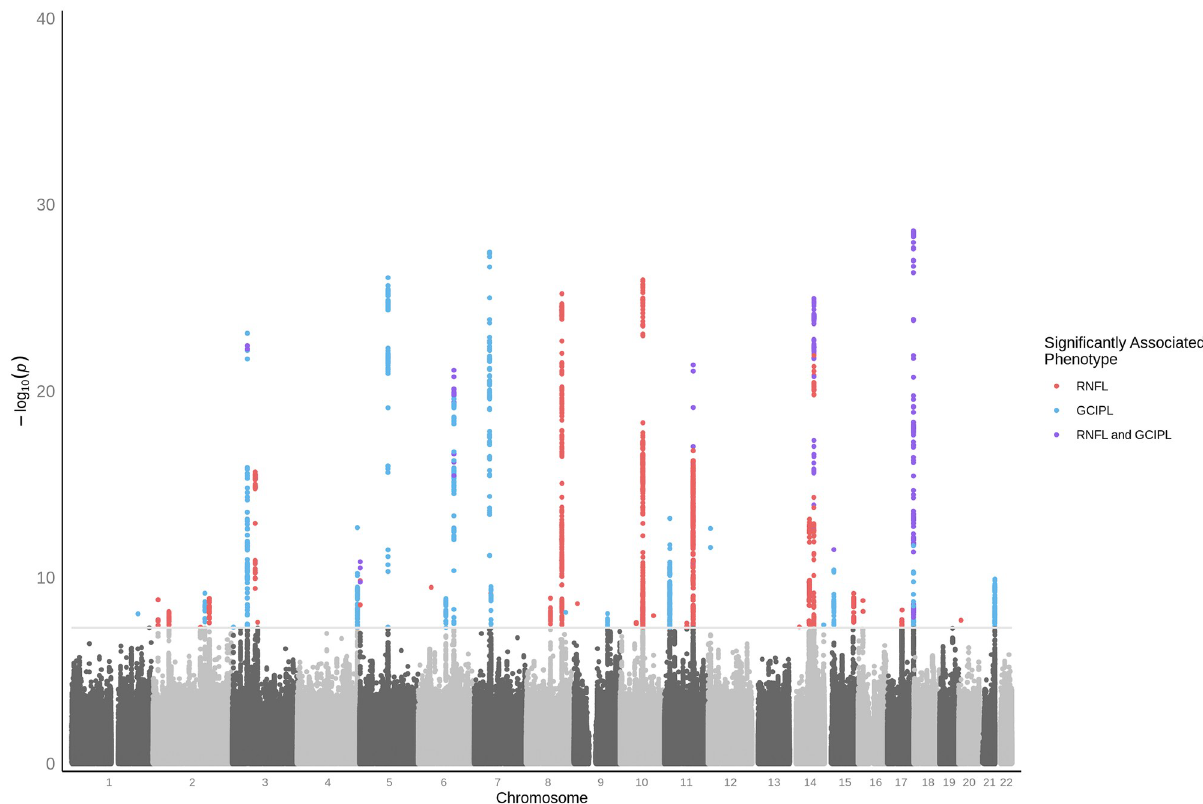
Fig 2. Genome-wide association study of inner retinal thickness phenotypes. Manhattan plot of inner retinal thickness phenotype GWAS p-values, resulting from meta-analysis across RNFL and GCIPL. Variants significantly associated (P < 5 × 10 -8 ) with only RNFL are highlighted in red, those significantly associated with only GCIPL are highlighted in blue, and those significantly associated with both inner retinal layers are highlighted purple.